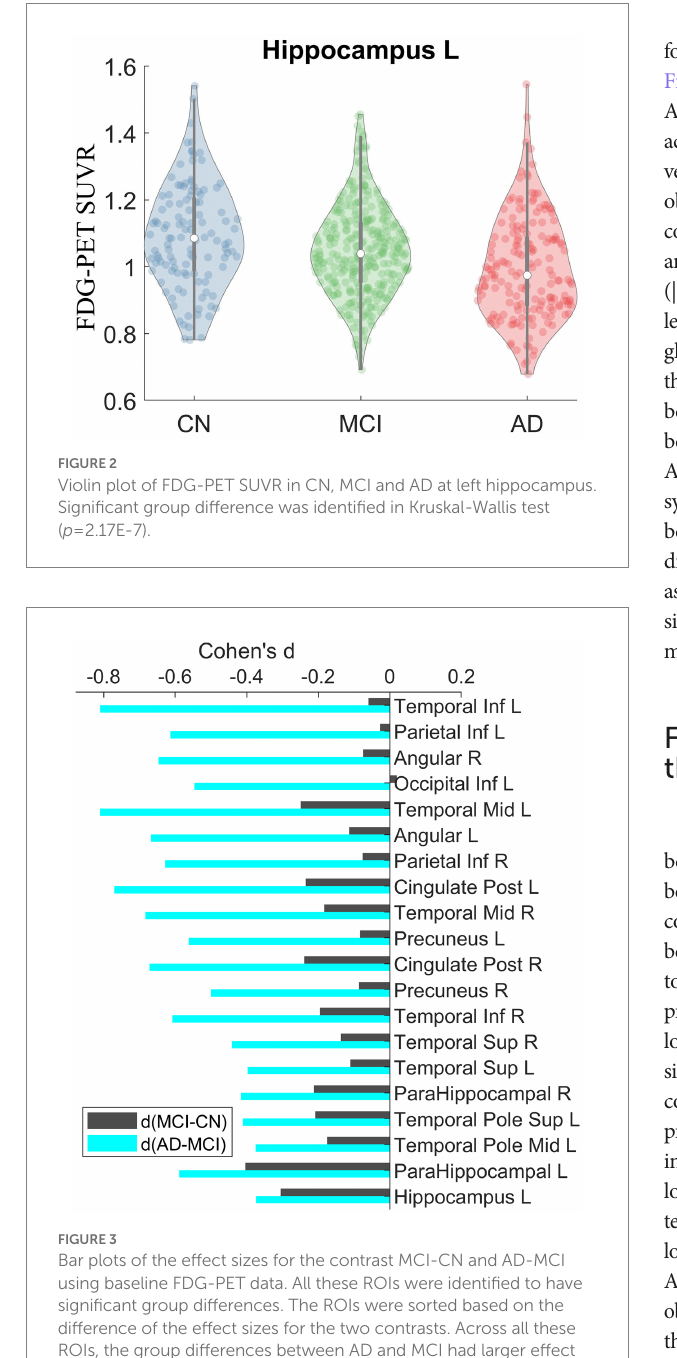
bilateral superior temporal lobe, bilateral middle temporal lobe and bilateral inferior temporal lobe, left superior temporal pole and left middle temporal pole. All these regions had the lowest SUVRs in the AD dementia group, intermediate values in MCI group, and the highest values in the CN group. No region showed higher FDG in the cognitively impaired (either MCI or AD) groups than the CN individuals. The observed hypometabolism at left hippocampus remained to be significant after regressing out hippocampal volume ( p = 0.0062 in Kruskal-Wallis test, see Supplementary Figure 1).